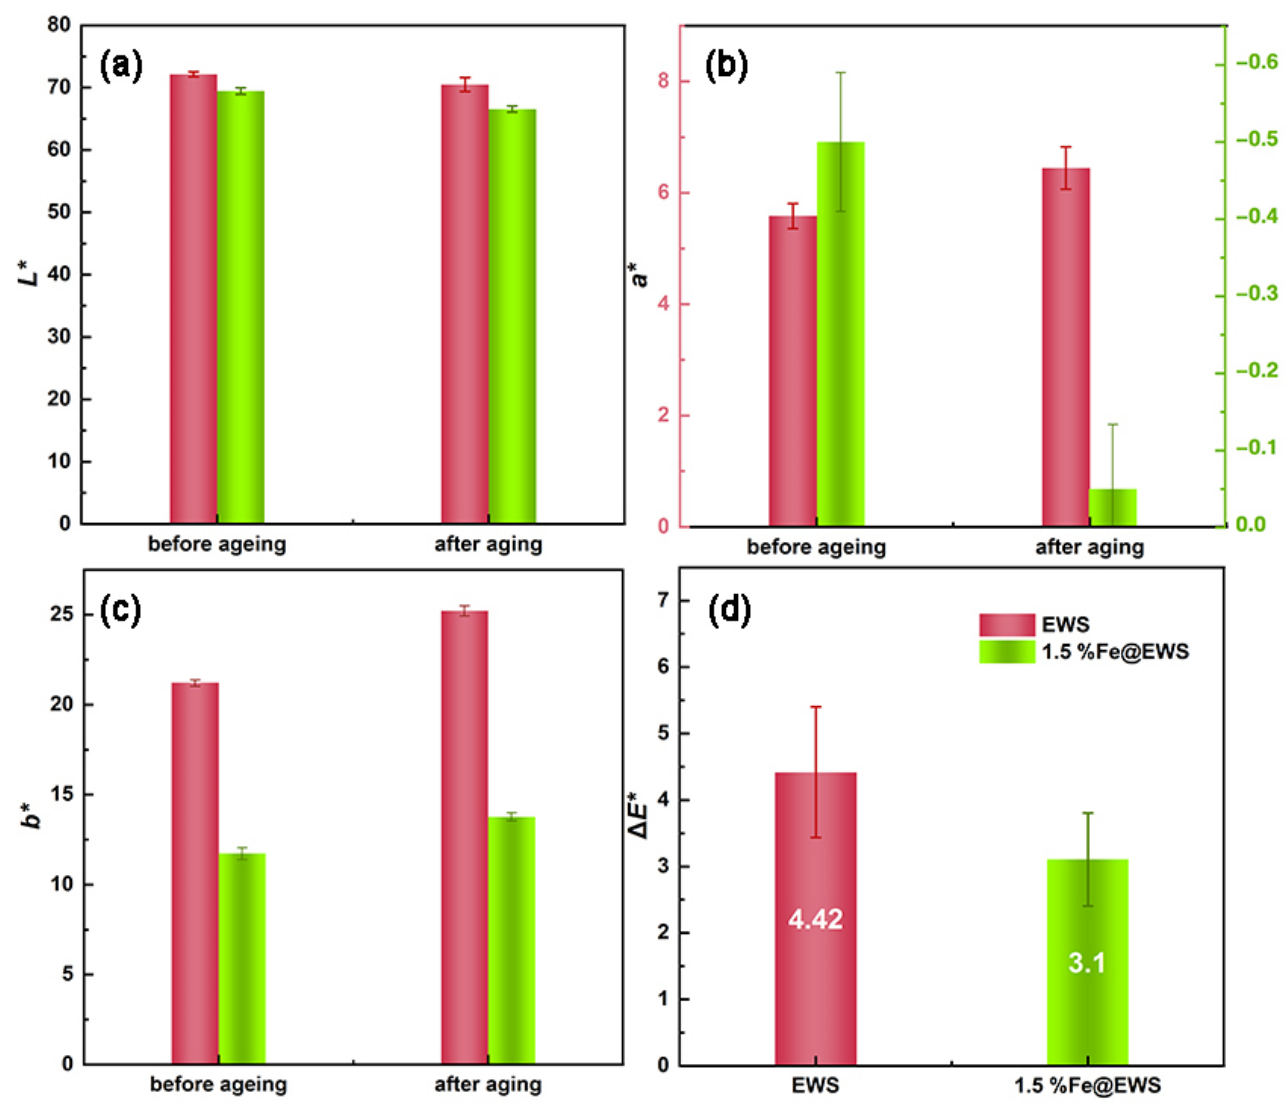
Figure 5. Changes in chromaticity coordinate L * ( a ), a * ( b ), b * ( c ), and Δ E * ( d ) of EWS and 1.5%Fe@EWS before and after photoaging testing.